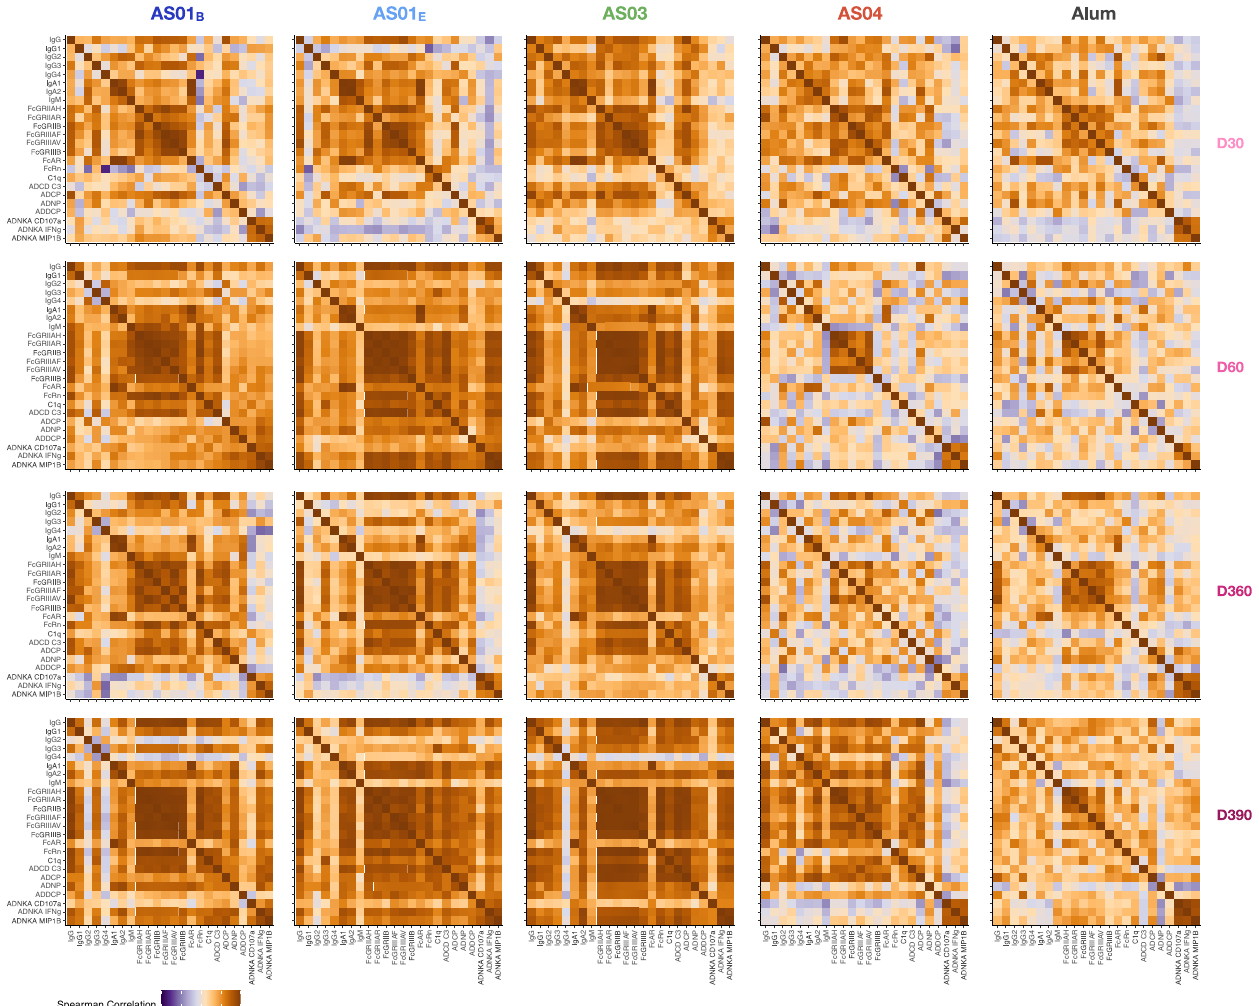
Fig. 2 Differences in correlation structures. Correlation heatmaps were generated for each adjuvant (column) at each time point (row), using Spearman rank correlations. For each adjuvant/time point, all correlations between humoral features were calculated, with orange indicating positive and purple indicating negative correlations. ADNP antibody-dependent neutrophil phagocytosis, ADCP antibody-dependent phagocytosis by THP-1 cells, ADCD antibody-dependent complement deposition, ADNKA antibody-dependent natural-killer cell activation. ADNP antibody-dependent phagocytosis by primary neutrophils, ADDCP antibody-dependent phagocytosis by monocyte-derived dendritic